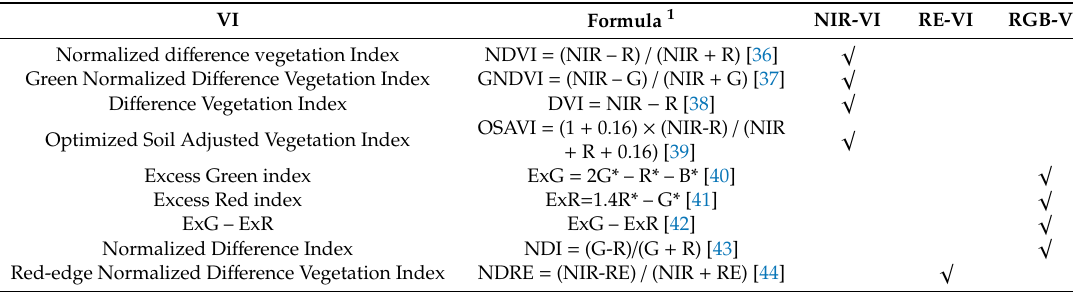
Table 3. Formulas of nine di ff erent VIs. VI Formula 1 NIR-VI RE-VI RGB-VI Normalized di ff erence vegetation Index NDVI = (NIR – R) / (NIR + R) [36]